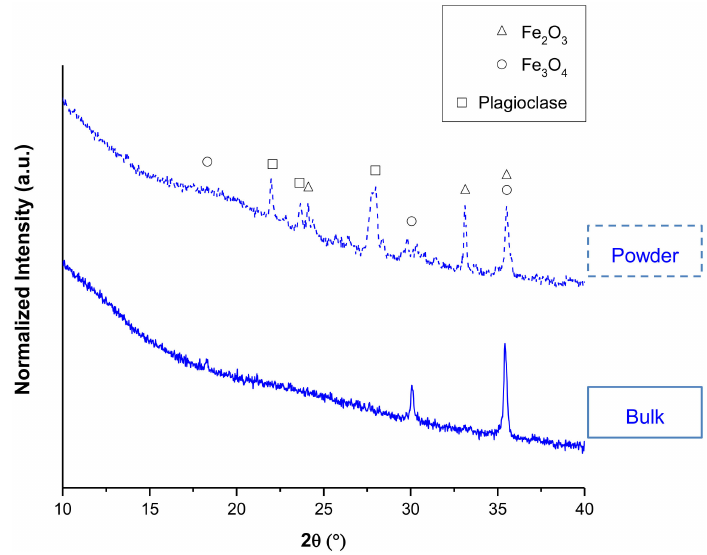
Figure 7. XRD spectra for bulk (solid line) and powder (dashed line) volcanic ash glass samples exposed to 1100 ◦ C for 1 h.